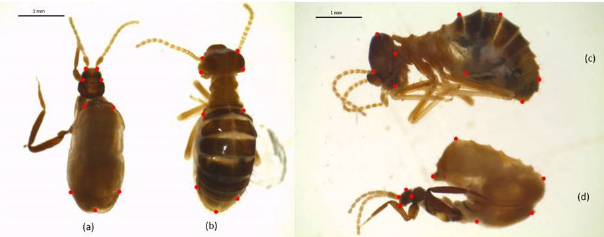
Fig 1 . Distribution of landmarks and semilandmarks in side and top view for Corotoca melantho and Constrictotermes cyphegaster workers. Four landmarks were marked on the basis of the antennas and the occipital area of the head in top view (a and b). Four landmarks were marked on the basis of the antennas, postoccipital area, the mandible tip and vertex of the head in side view (c and d). Five semilandmarks were marked representing the first and penultimate tergites and the apical tip of last tergite of the abdomen in top view (a and b). Five semilandmarks were marked representing the first, middle and ultimate tergites and the middle sternite of the abdomen in side view (c and